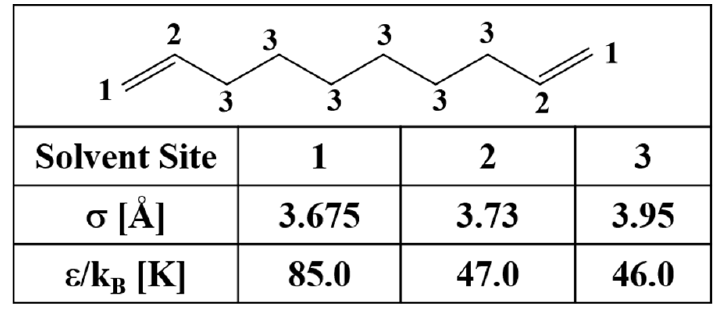
Figure 1. Atomic size parameters of the 1,9-decadiene solvent used in this work. Two-dimensional molecular descriptor generation: Molecular descriptors were gen- erated from the corresponding SMILES strings of the solute molecules using the publicly available PaDEL-Descriptor software [41].